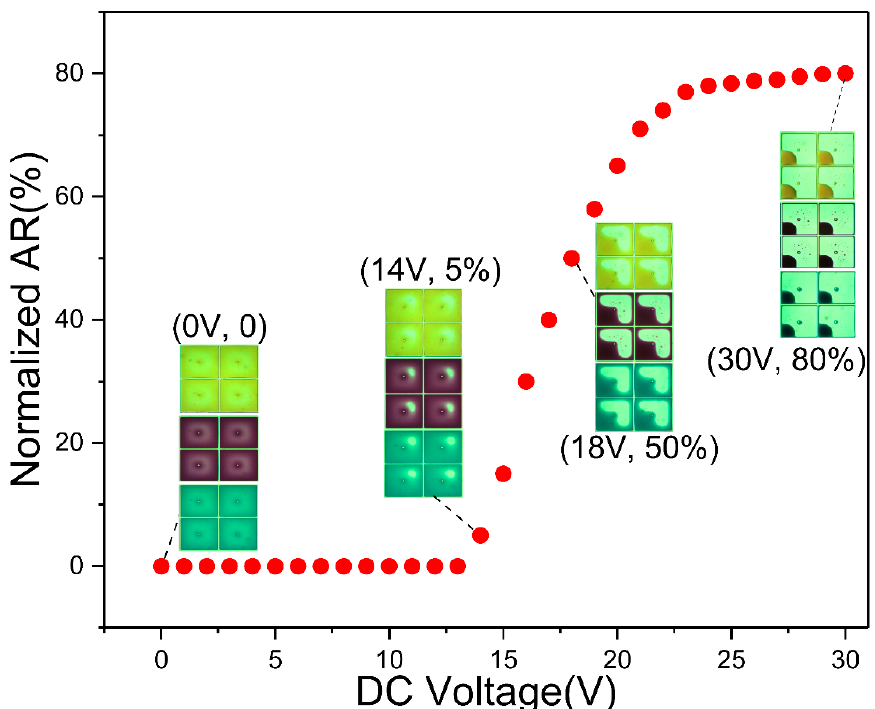
Figure 6. Normalized AR versus the applied voltage of the EWD elements.